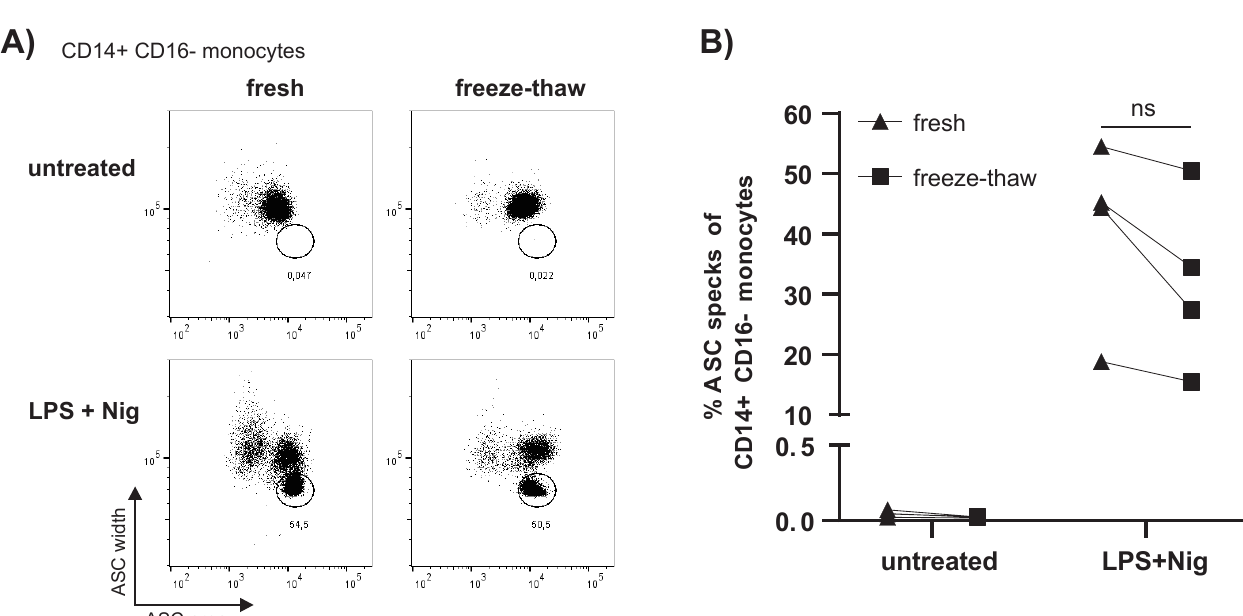
Figure 2. Isolated PBMCs can be frozen for long-term storage without spontaneous ASC speck formation. ( A , B ) ASC speck formation in CD14 ++ CD16 − monocytes either freshly isolated or after one freeze–thaw cycle with or without stimulation with LPS 4 h and Nig 20 min. ( A ) Representative dot plots and ( B ) quantification of data tested with two- way ANOVA followed by Bonferroni multiple comparison test ( n = 4, individual frozen away and thawed together). ns: no